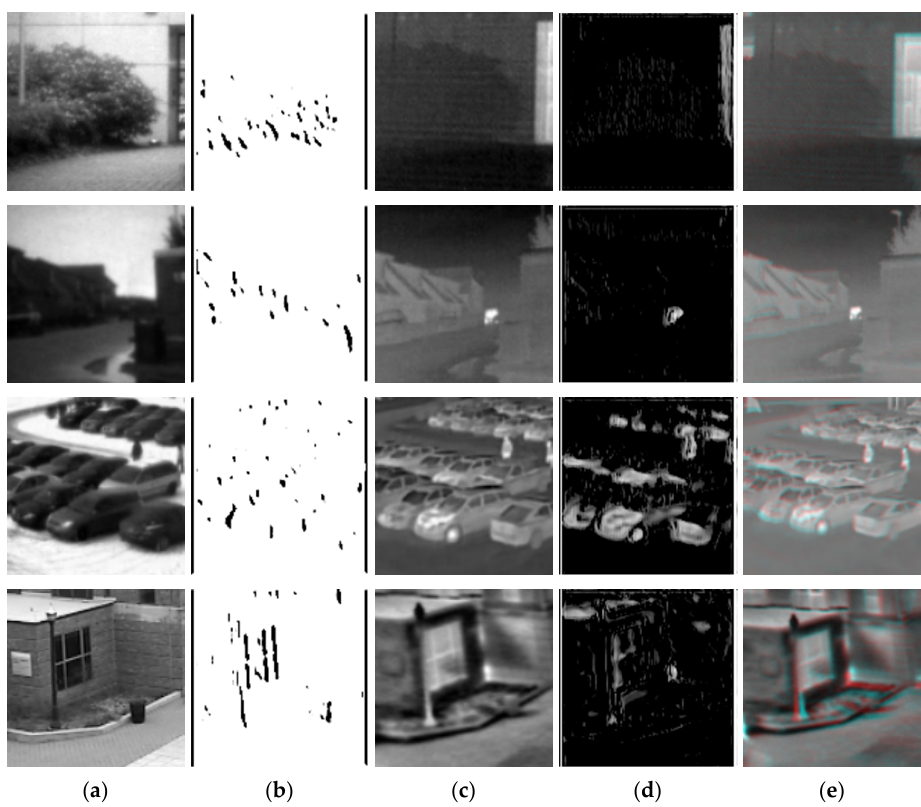
Figure 7. Fine-feature maps and channel mixing visualization results of our HomoMGAN. From left to right: ( a ) visible image patch I v , ( b ) visible fine-feature map F v , ( c ) infrared image I r , ( d ) infrared fine-feature map F r , and ( e ) channel mixing result between the warped infrared and the ground-truth image. It is worth noting that the warped image is obtained by transforming the infrared image according to the homography matrix predicted by our method.